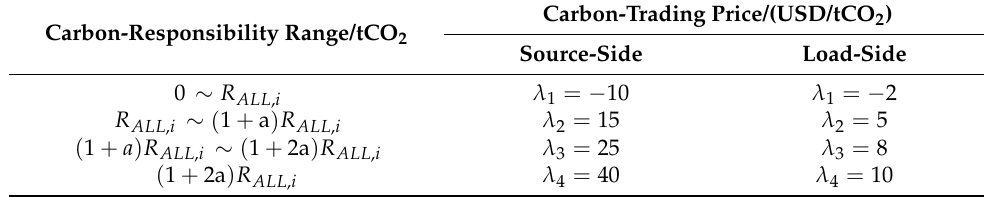
Table 4. Bilateral ladder-type carbon-trading parameters.